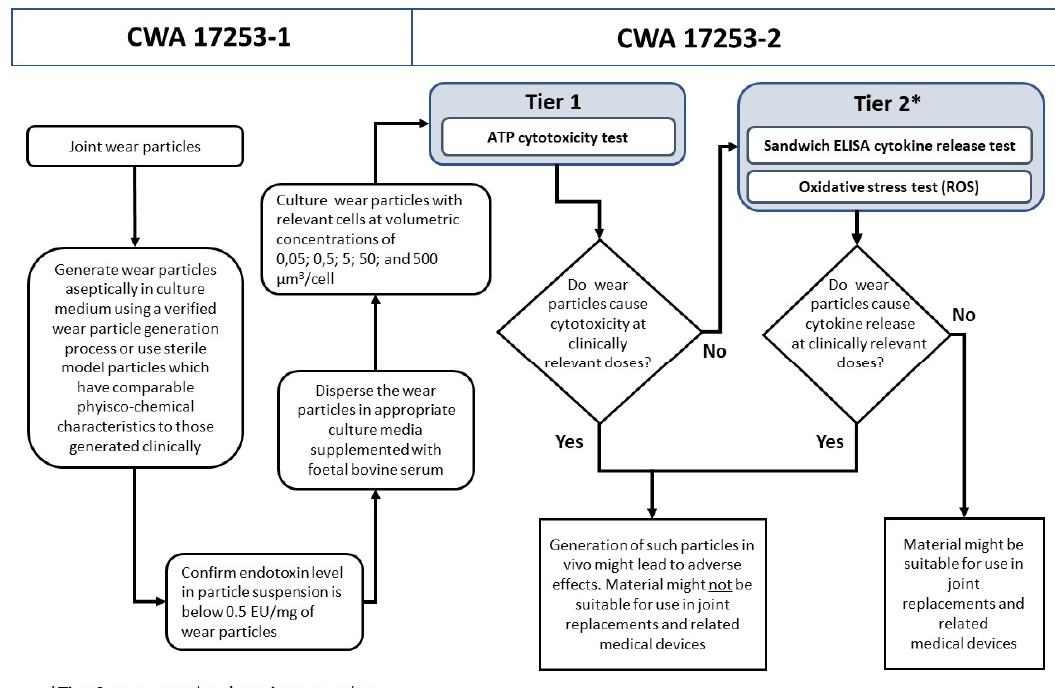
Figure 4. Tiered toolkit flow diagram for evaluating the biological impact of polyethylene wear particles from joint replacements and related medical devices (CWA = CEN Workshop Agreement).